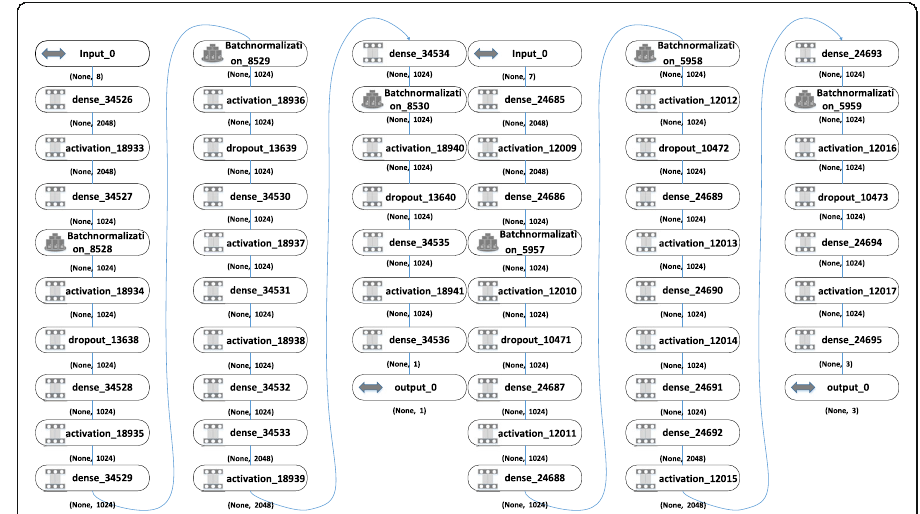
Fig. 2 Proposed model architecture. The model was created and trained on the Deep Learning Studio by Deep Cognition AI. The platform simplifies and accelerates the process of working with deep learning across popular frameworks such as TensorFlow and MXNet. By using advanced pretrained networks such as the Mask RCNN, DenseNet, MobileNet, InceptionV3, ResNet, and Xception, complete custom networks can be created in seconds with an AI Wizard on Deep Learning Studio. The feature vector is directly fed into the input nodes of the network. Each node generates an output with an activation function, and the linear combinations of the outputs are linked to the next hidden layers. The activation functions among different layers are different. Then, the features are retrieved and the retrieved features are concatenated to form a new feature vector. The output layer ’ s activation function is the softmax. The softmax classifier uses the new feature vector to get the confidence of each relation. The dimension of the output vector is the number of classes, while the confidence of each classification equals the value of each dimension. The number of neurons in the input layer is the same as the input feature dimension, and the number of neurons in the output layer is the same as the output classes. For the neurons in the input layer, they receive a single value on their input and are sent to all of the hidden nodes. The nodes of the hidden and output layers are active, and each layer is fully interconnected. The output layer is responsible for producing and presenting the final network outputs, which are generated from the procedure performed by the neurons in the previous layers. During the training process, the input feature goes through the input nodes at the bottom of the deep learning network, where the weights are initialized with random values. After that, the weight vectors are fine-tuned in sequence. The main training goal is to minimize the loss function and maximize the accuracy function of the